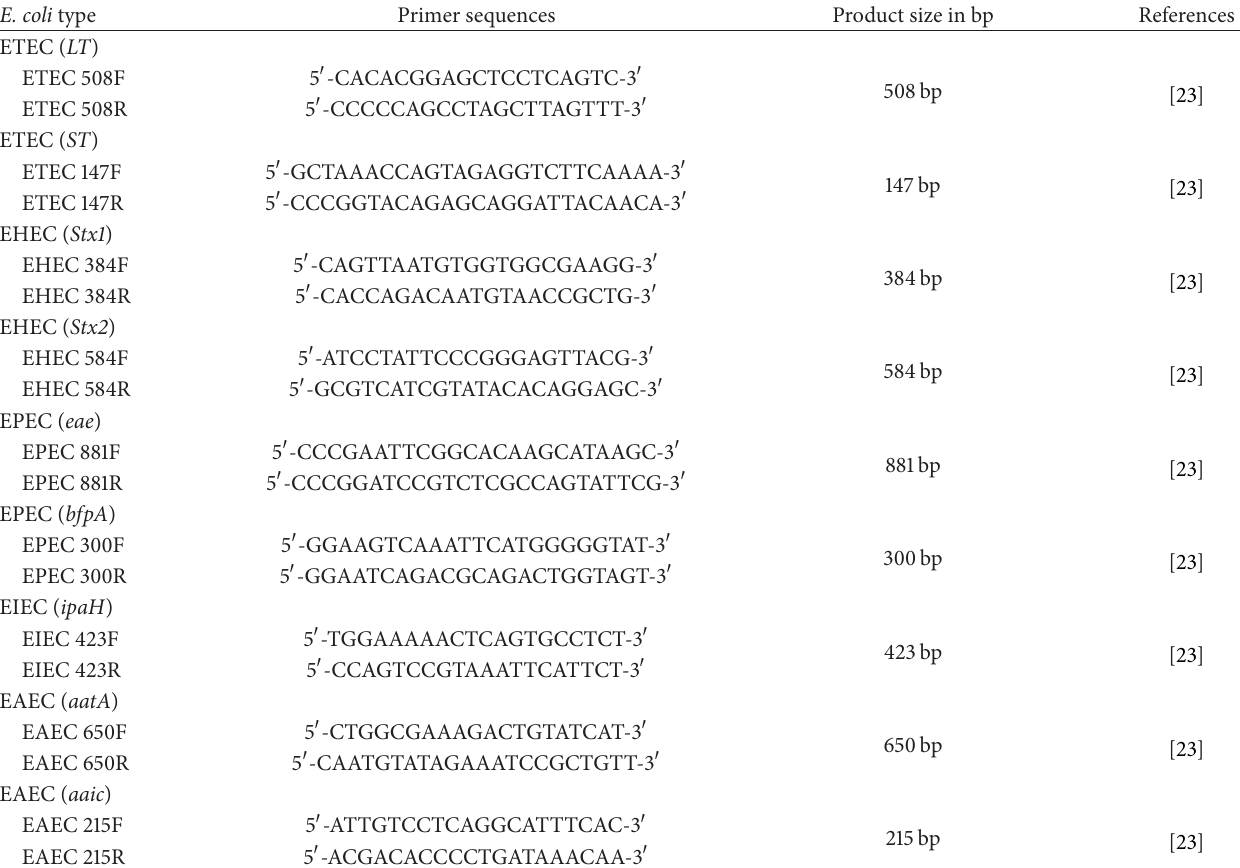
Table 1: Primer sequences used in multiplex PCR for detection of pathogenic E. coli